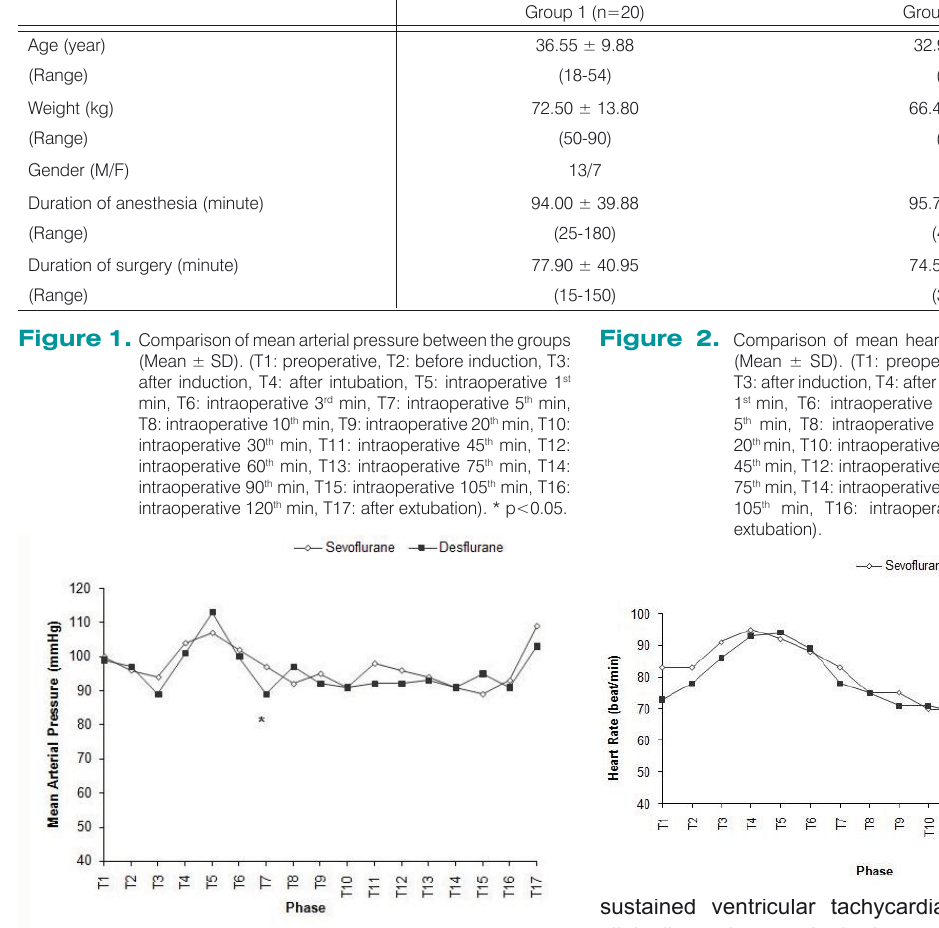
Table 1. Demographic data, duration of anesthesia and duration of